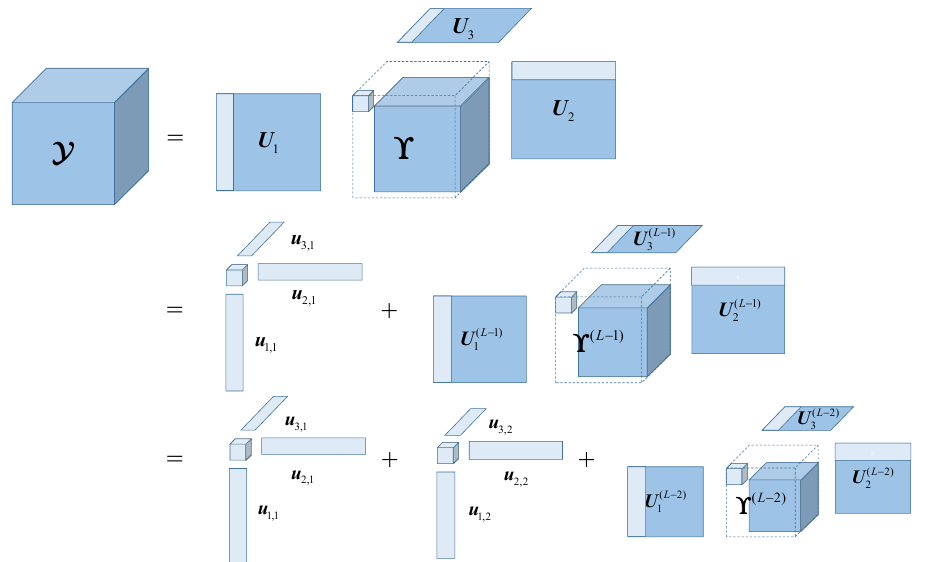
Figure 2. Subspace dimensionality reduction tensor decomposition model. The process of the first two dimensionality reduction decompositions is used here as an example, and the subsequent decompositions will be performed in the reduced